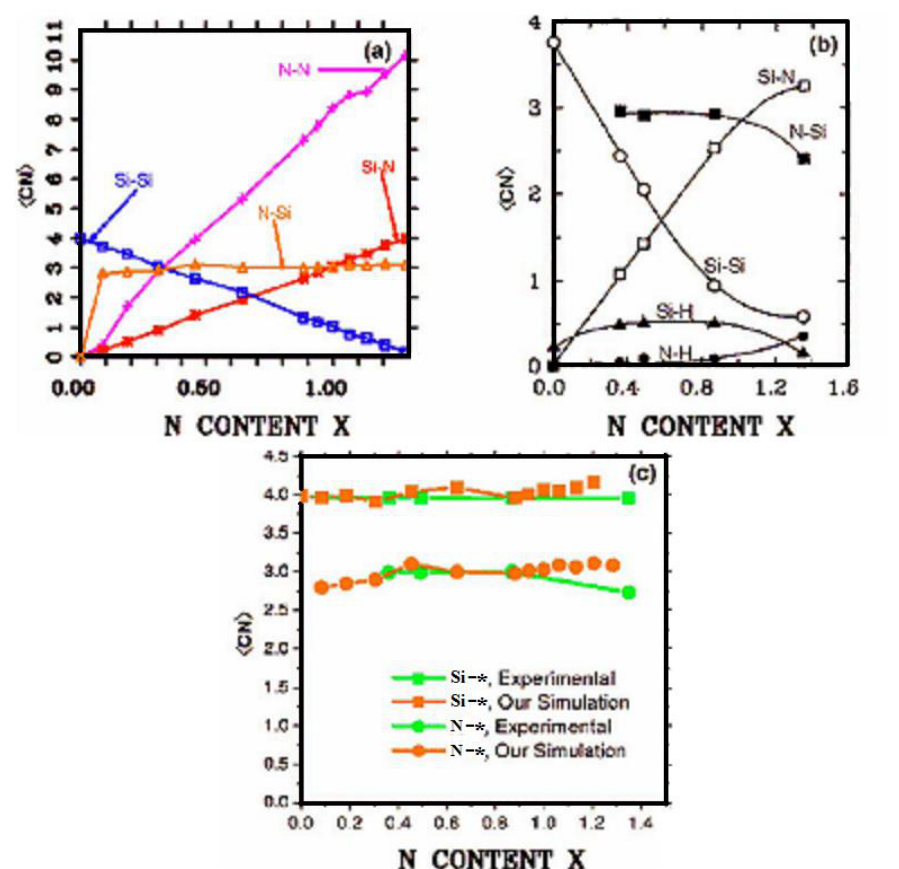
Figure 10. Average coordination numbers < cn > as a function of x . ( a ) Our results; ( b ) Experimental results for hydrogenated alloys from Guraya et al. [59]; ( c ) Comparison of the integrated results (see text). Lines are drawn as guides to the